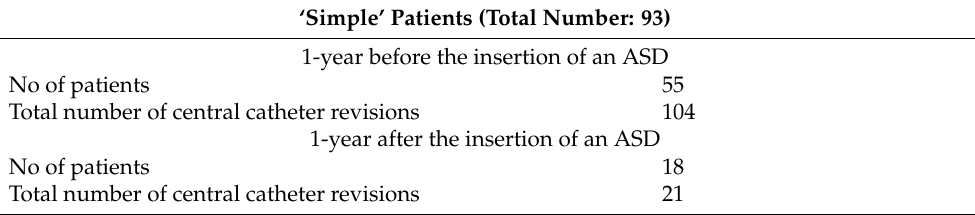
Table 4. Comparison of the number of patients who underwent revision of the proximal catheter in a time period of one year before and one year after the insertion of an ASD, in the subgroup of ‘Simple’ patients.